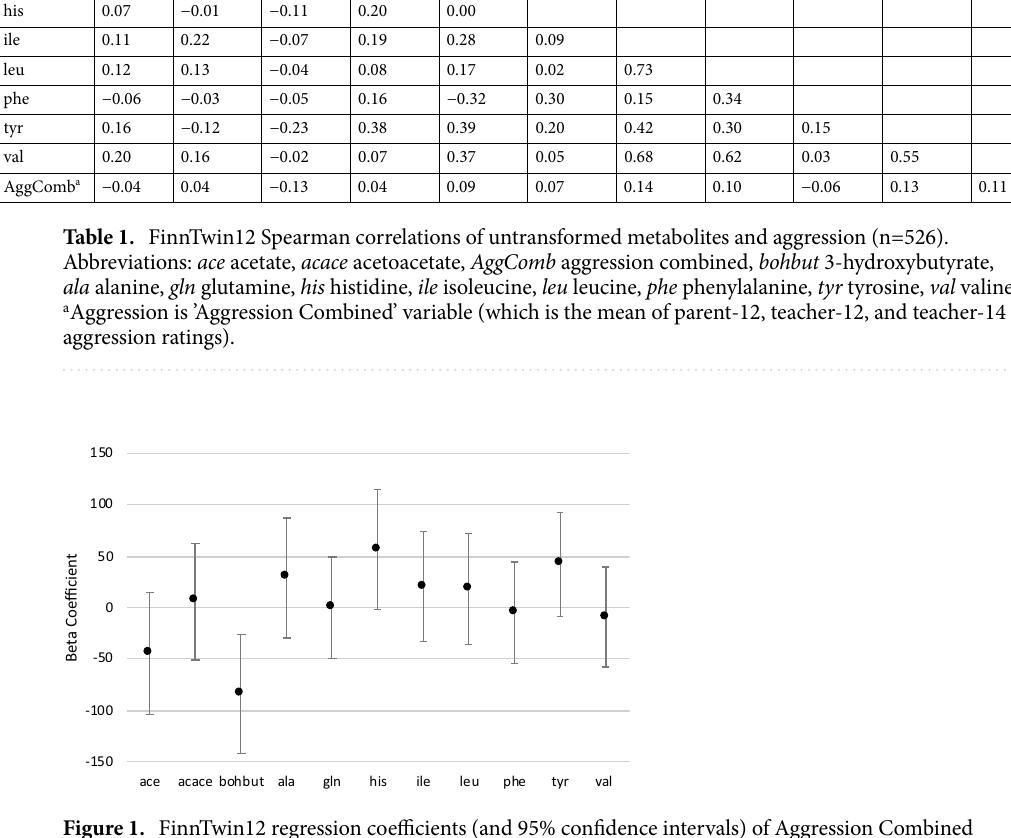
Figure 1. FinnTwin12 regression coefficients (and 95% confidence intervals) of Aggression Combined predictor variable in linear regression models with metabolites as response variables, adjusted for age, sex, body mass index, and familial relatedness. ace acetate, acace acetoacetate, bohbut 3-hydroxybutyrate, ala alanine, gln glutamine, his histidine, ile isoleucine, leu leucine, phe phenylalanine, tyr tyrosine, val valine.